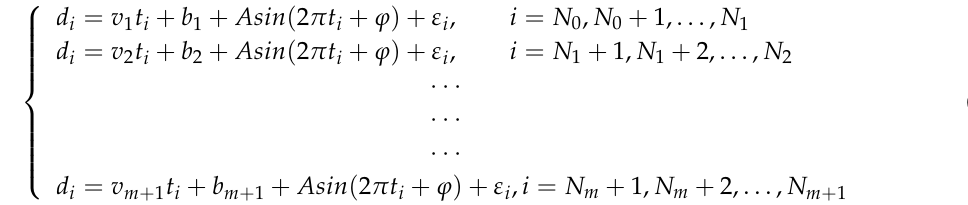
Figure 7. Photos of the analyzed building. A large foundation ditch is present on the south of the building ( a ). Cracks are visible on the building ( b ), confirming our analysis from InSAR data.